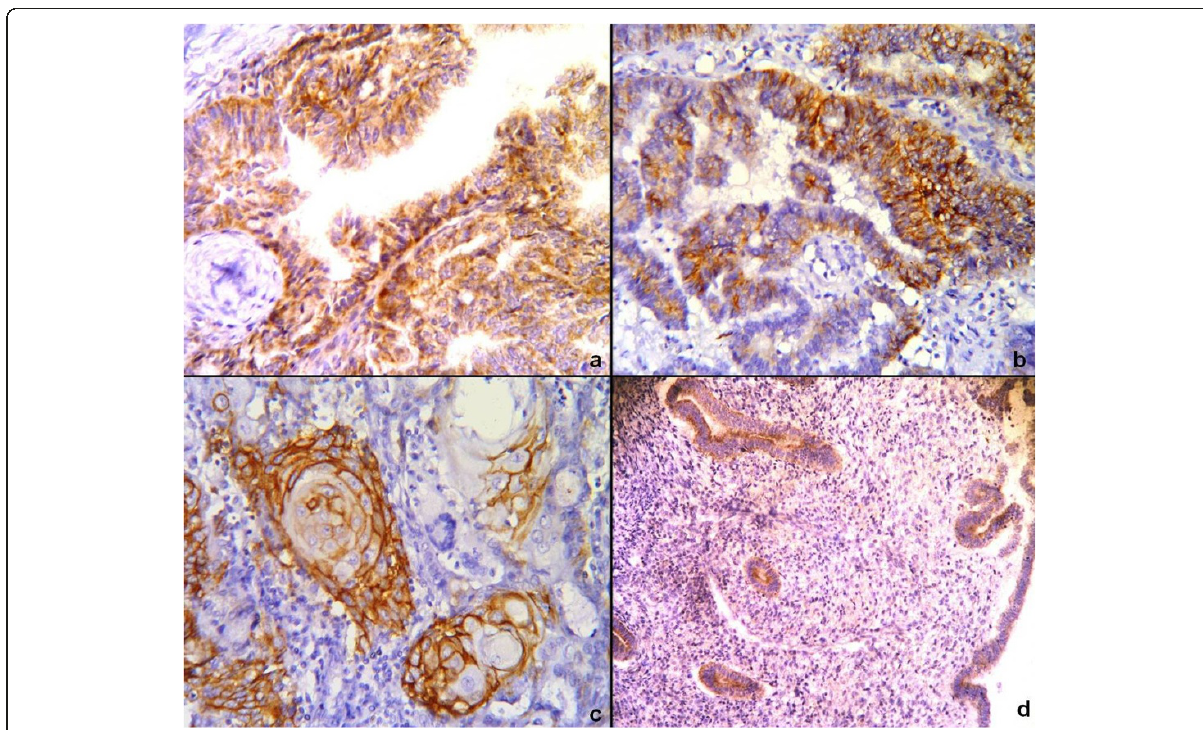
Figure 2 Immunohistochemical staining for CD44v6. ( a ) Cytoplasmic expression in tumour glands. ( b ) Focal membranous staining in the tumour. ( c ) Squamous differentation areas showing strong expression. ( d ) Weak expression in the glands of proliferative endometrium. B-SA peroxidase, DAB: [( a ) – ( c )]×200 and ( d